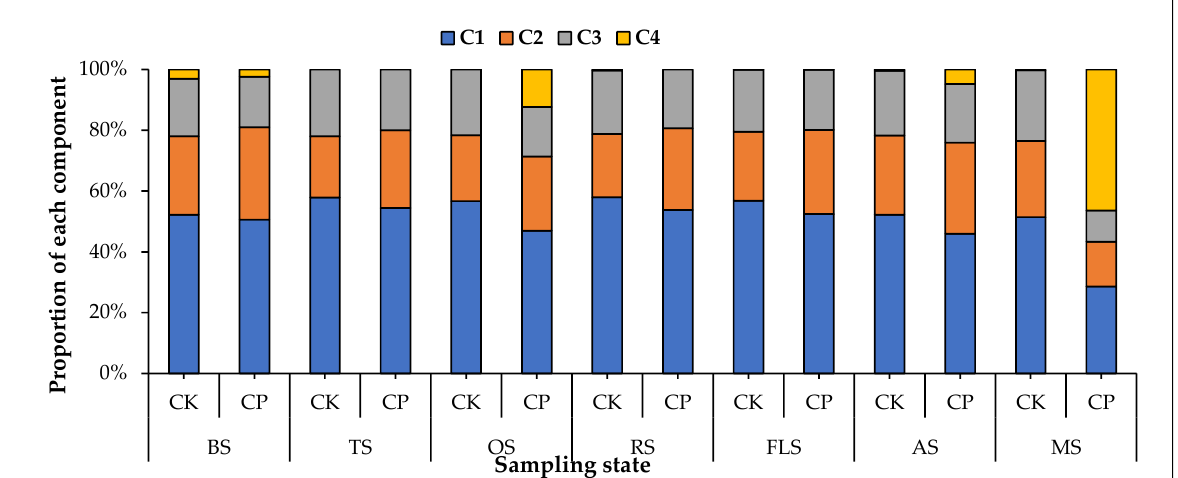
Figure 4. The proportion of soil DOM fluorescence components obtained by PARAFAC.CK, no fertilizer application. CP, applying organic fertilizer. BS, before sowing. TS, at the tillering stage. OS, overwintering stage. RS, rising stage. FLS, flag leaf stage. AS, anthesis stage. MS, maturity stage. C1, UV and UVA humic-like. C2, tryptophan-like and UVA humic-like. C3, Exogenous and visible humic-like. C4,